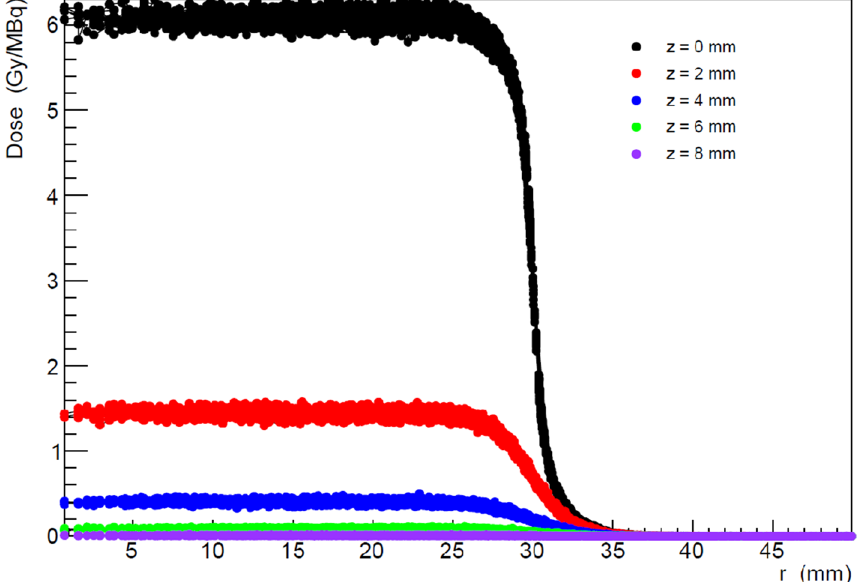
Figure 2. Dose values per unit of activity (Gy/MBq) in each voxel located on planes at fixed distances from the tumour bed (colour code) as a function of the radial distance r from the center of the treated region. The values are obtained for a circular tumour bed with R = 30 mm and for a BAT-90 thickness t = 0 mm. The plot illustrates the steep fall of the dose when moving away from the tumour bed, both in z and in r, and the homogeneity of the dose values obtained in the tissue adjacent to the treated region.